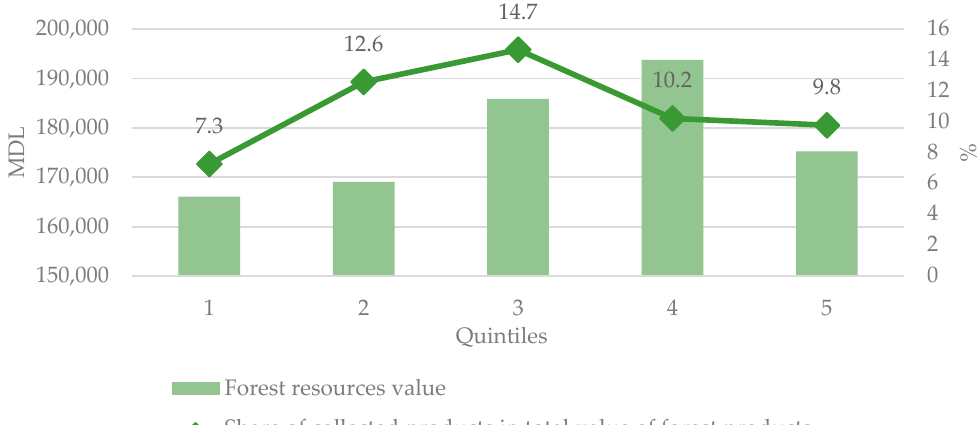
Figure 6. Share of collected products in total value of forest products (collected plus procured) by income quintile.